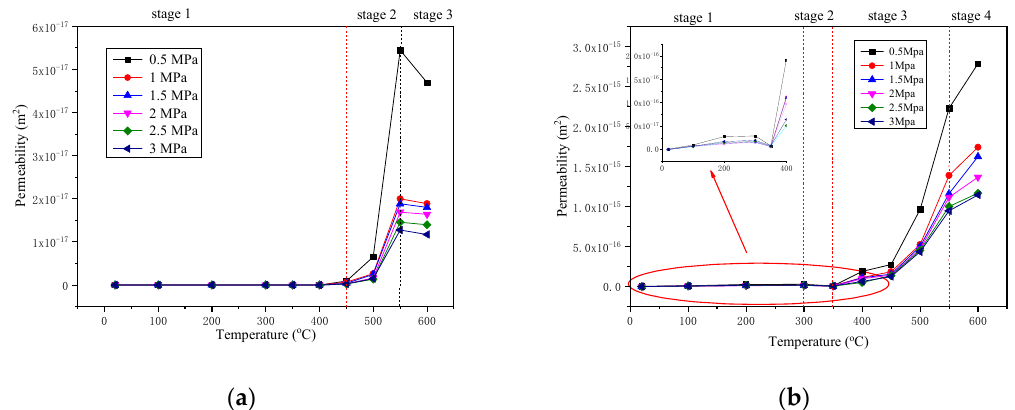
Figure 12. Variation of permeability at different temperatures(Wang et al.[31]): ( a ) Variation of permeability perpendicular to the sedimentary bedding with temperature; ( b ) Variation of permeability parallel to the sedimentary bedding with temperature.